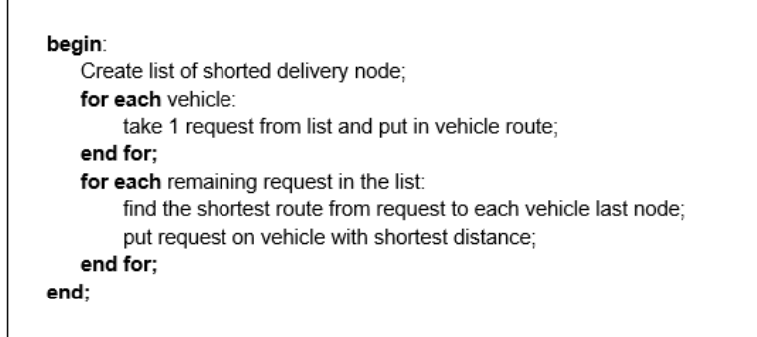
Figure 2. A pseudocode of the initial solution.